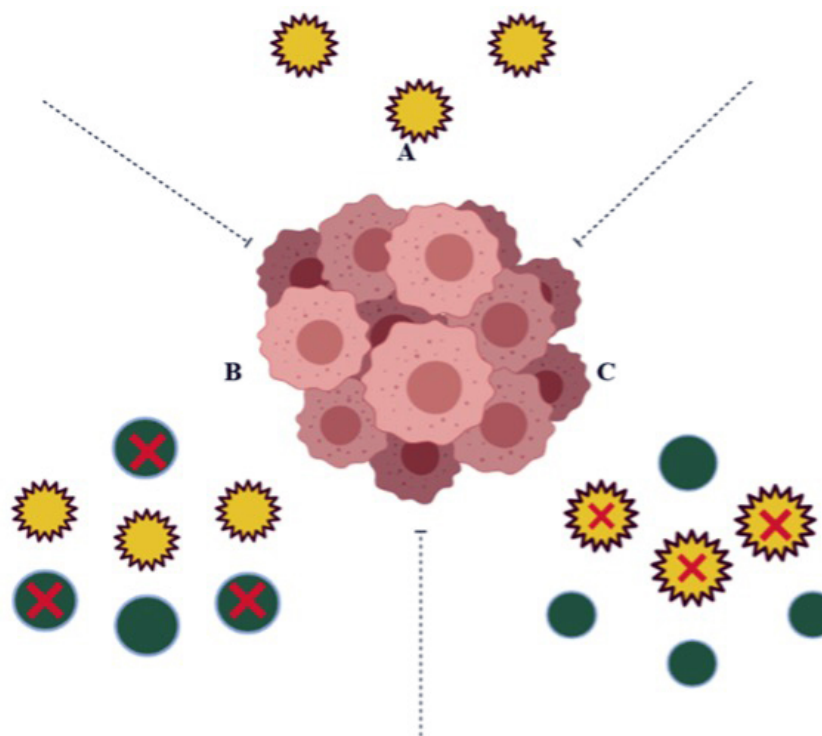
Figure 2. In some cases, ( A ) the expression levels of NQO1 (yellow circles) in a normal cell play a vital role in protecting the cells against harmful components; ( B ) in cancer cells, the over expression of NQO1 detoxifies Quinine molecules (green circles) resulting as Quinone resistant; ( C ) the inhibition of NQO1 in cancer cells avoids Quinone detoxification and shows susceptibility to anti-cancerous agents. The high amount of NQO1 in cancer cells is thought to help them cope up with oxidative stress, just as they do in healthy cells. Studies of transcription factor Nrf2, which controls NQO1 expression, have partially supported this hypothesis. Gain-of- function mutations in Nrf2 or loss-of-function mutations in Keep over-activate Nrf2 in many cancers, including lung, pancreas, liver, gall bladder, and ovarian cancers [12]. Nrf2 like over expression of NQO1. The mechanism by which NQO1 is over expressed via Nrf2 Keap1 cause the lowest binding with Nrf2 and drive the expression of NQO1. In